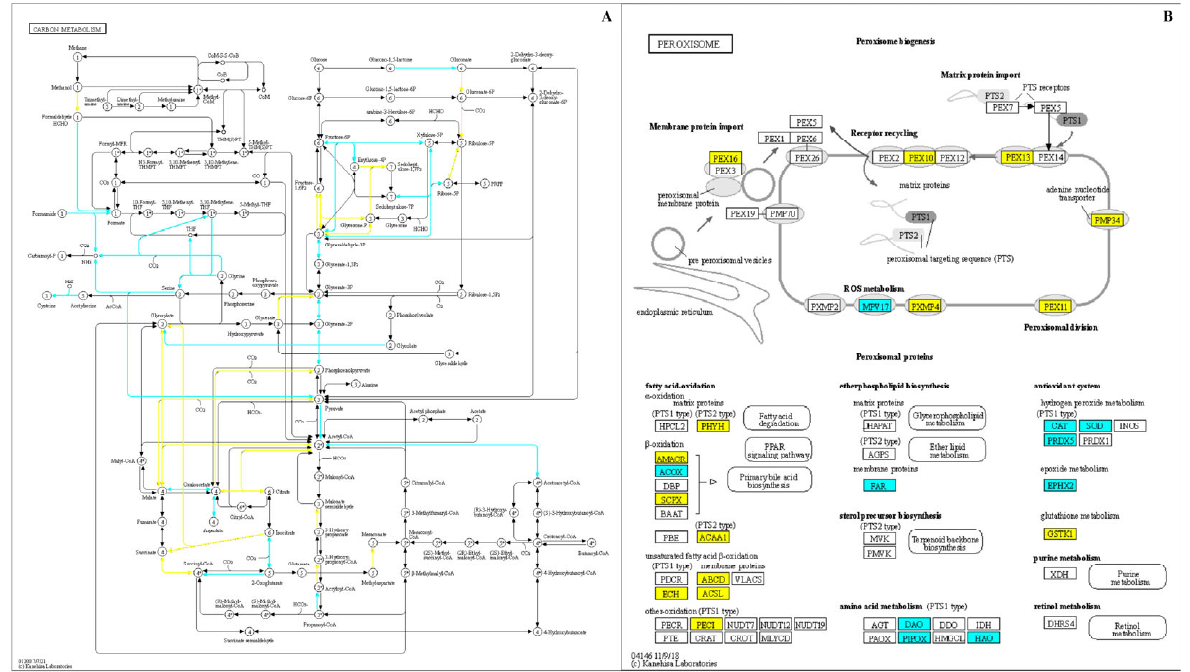
Figure 6. Kyoto Encyclopedia of Genes and Genomes (KEGG) maps of select metabolic pathways showing differentially expressed genes in the highly virulent strain Penicillium expansum R19. Select genes differentially regulated (log 2 fold change ≥ 2, p < 0.05) in R19 between ramifying hyphae and mycelium from apple and ungerminated conidia. DEGs comprising ( A ) carbon metabolism and ( B ) peroxisomal biochemical functions are highlighted in yellow (high in ungerminated conidia) or cyan (high in decayed apple). Images generated using Kegg.com.